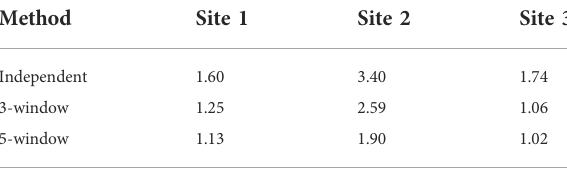
TABLE 4 Total temporal roughness of independent and windowed inversions relative to full sequence 4D